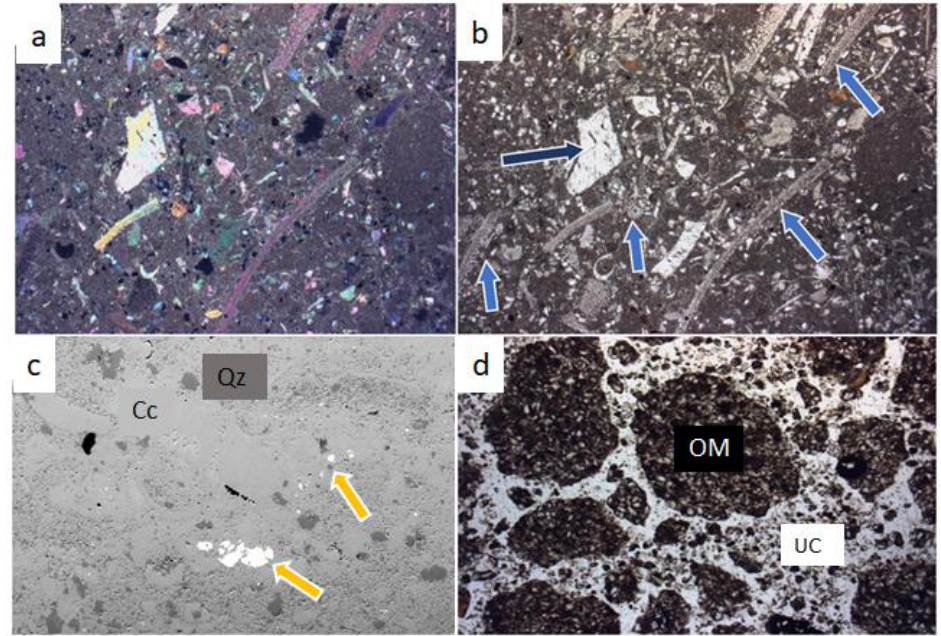
Figure 4. Petrographic analysis images of ( a ) cross polarized light (XPL) image of rock sample thin-section; ( b ) plane polarized light (PPL) of rock sample thin-section with abundant fragments of sea urchins (light blue arrows) and minor bivalves (dark blue arrow); ( c ) Backscattered electron image (BSE) of rock sample thin-section indicate abundance in calcite (Cc), minor quartz (Qz) and some hematite (Fe 2 O 3 ) and barite (BaSO 4 ) grains (yellow arrows); ( d ) soil sample thin-section showing mostly unconsolidated carbonate (UC) with organic matter (OM).